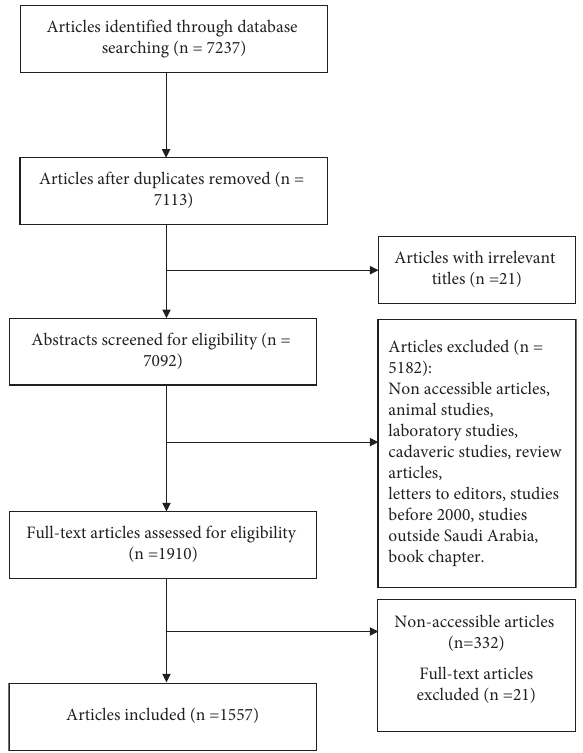
Figure 1: Schematic presentation of the review